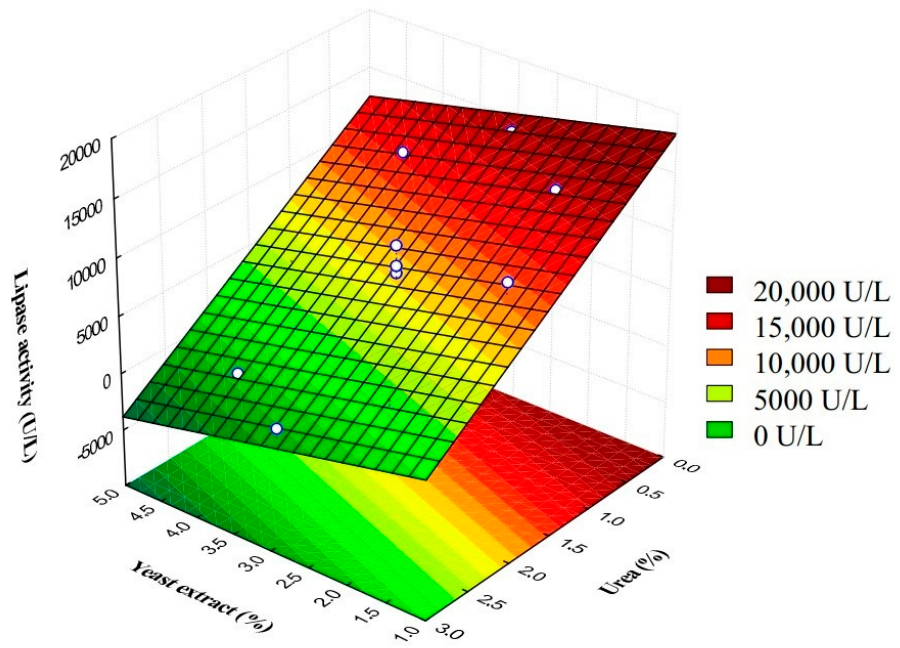
Figure 3. Response surface of the central composite rotatable design (CCD) for extracellular lipase production by Y. lipolytica cultivated in Erlenmeyer flask for 16 h with PSR supplemented with yeast extract and urea.